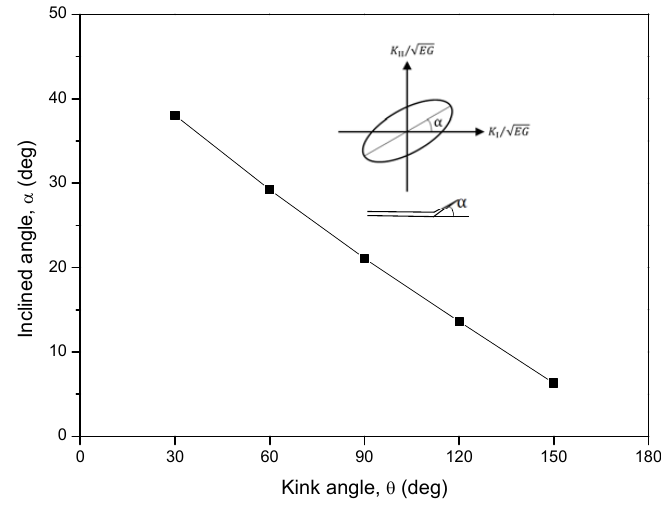
Figure 6. Inclined angle of the Iso-energy release rate.